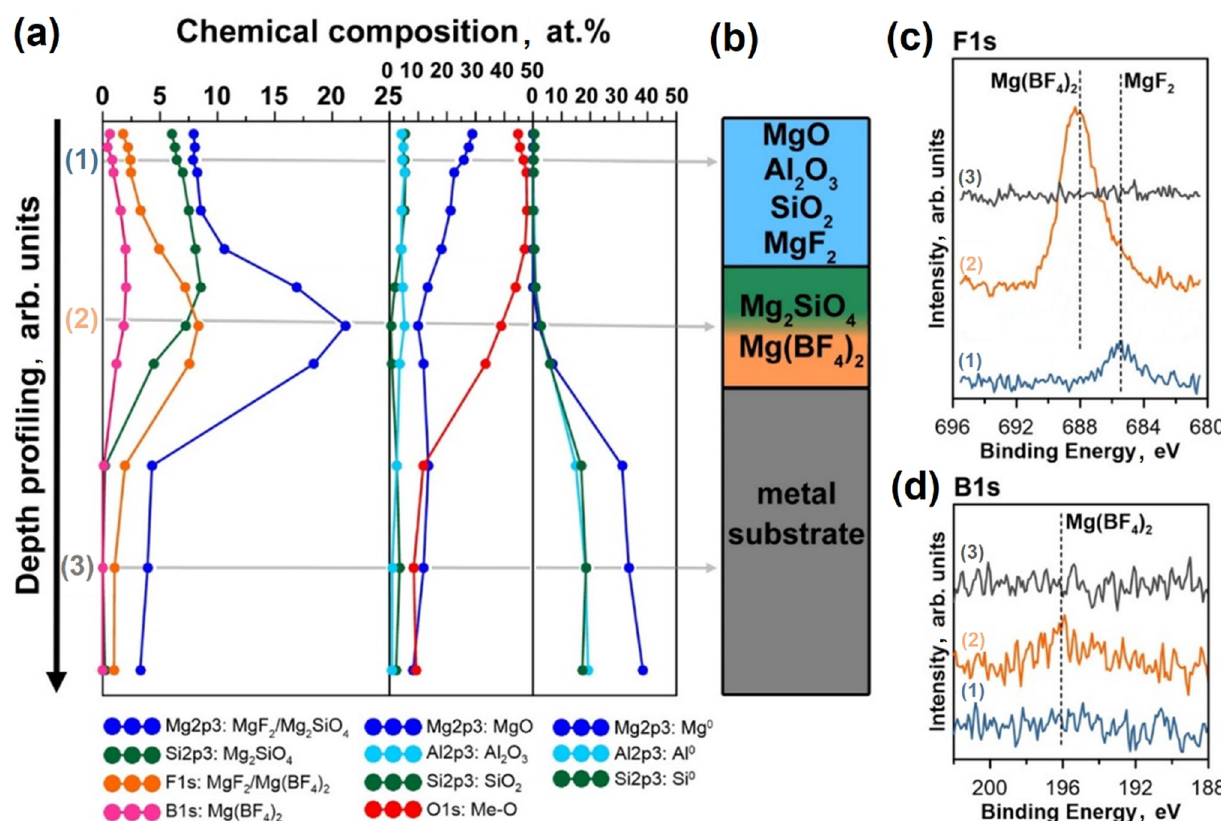
Figure 7. XPS analysis of the BF4 coating: ( a ) the chemical composition of the depth profile; ( b ) the cross-section scheme; ( c ) specific spectra of fluorine (F 1s) and ( d ) boron (B 1s) at the outer layer (point 1); inner layer (point 2); and metal substrate (point 3).